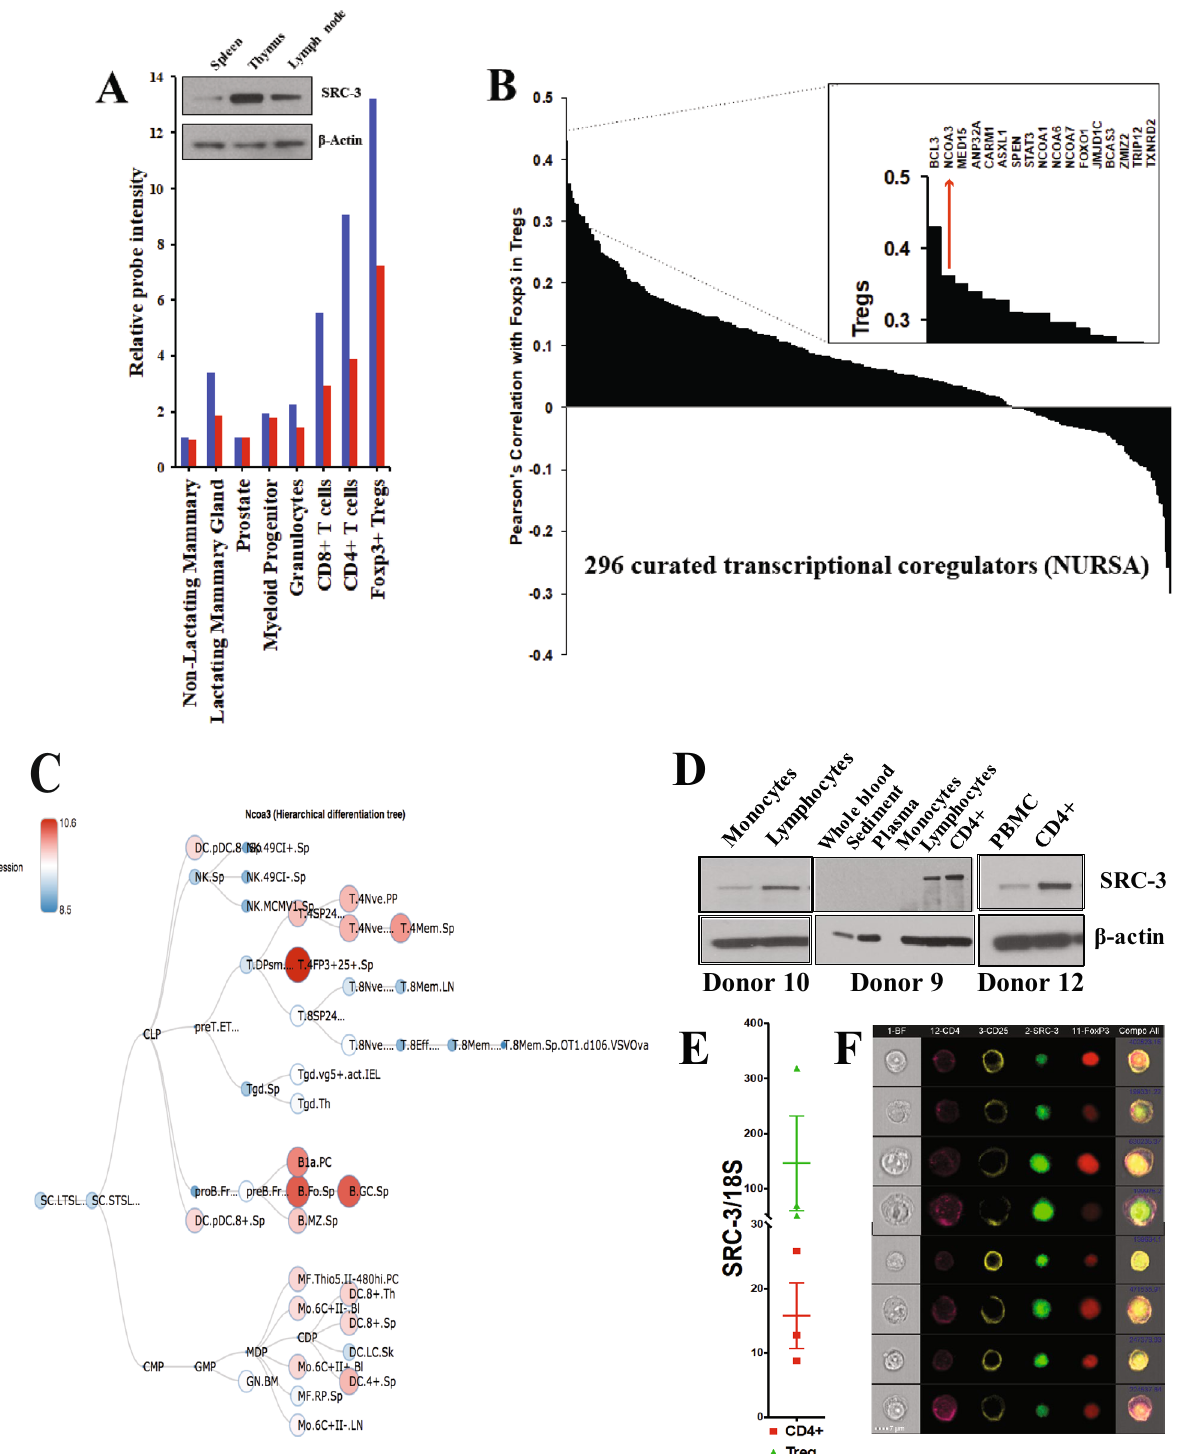
Figure 1. Steroid Receptor Coactivator 3 (SRC-3/NCOA3) is highly expressed in Tregs. ( A ) Ncoa3/Src-3 probe intensity in various tissues from BioGPS database (Gel image cropped from original blot submitted as supplemental figures) and the blue and red bars each represent expression values from two different probes from the microarray used in the BioGPS database. ( B ) Correlation of expression between NURSA coactivators and Foxp3 in Tregs using ImmunoNavigator. ( C ) Hematopoietic lineage map of Ncoa3/Src-3 expression showing highest levels in CD4 + CD25 + FOXP3 + Tregs in the spleen. ( D ) Fractionation of human blood shows elevated SRC-3 protein levels in CD4 + lymphocytes (Gel image cropped from original blot submitted as supplemental figures). ( E ) Enriched transcript levels of SRC-3 in freshly isolated Tregs in humans. ( F ) Imaging cytometry shows SRC-3 protein expression in CD4 + CD25 + FOXP3 + human